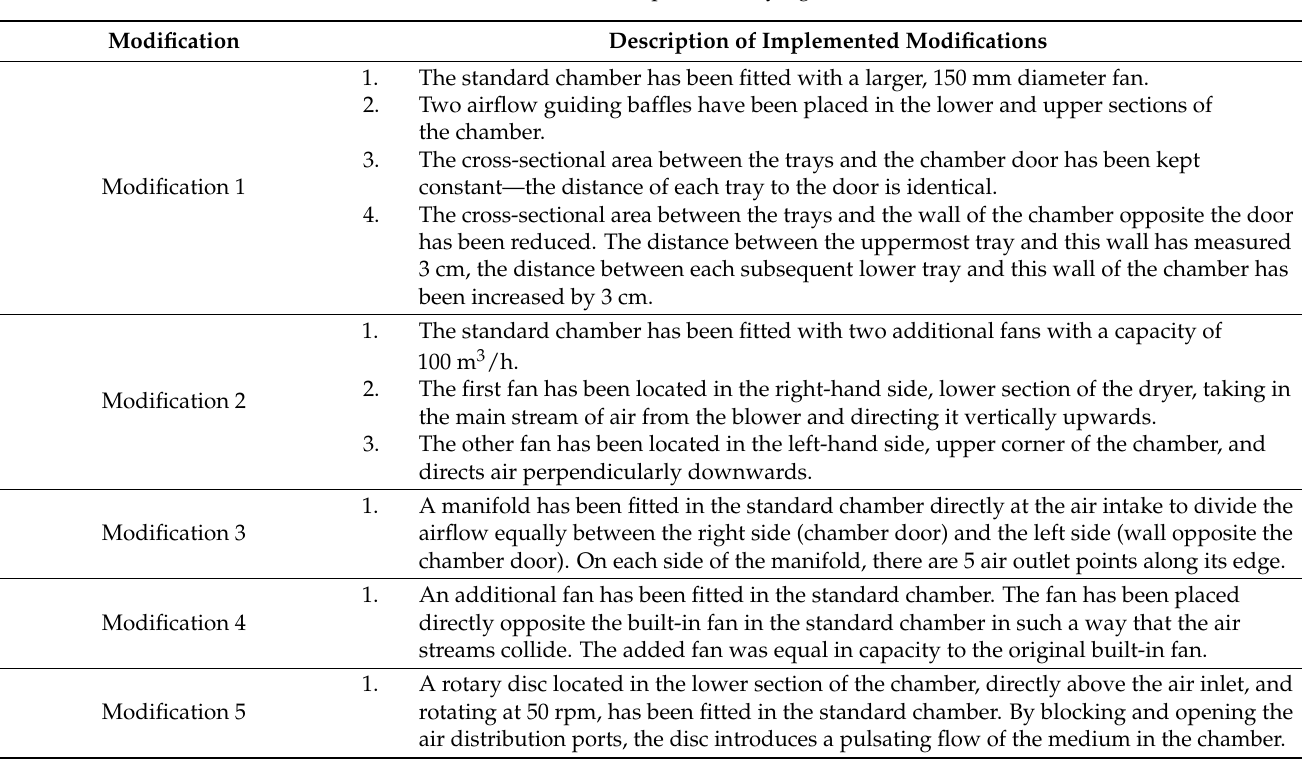
Table 1. Modification scope of the drying